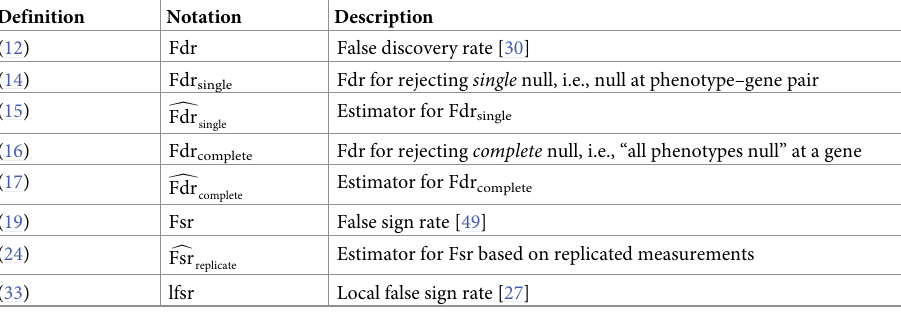
Table 3. Glossary of error rates referred to in this